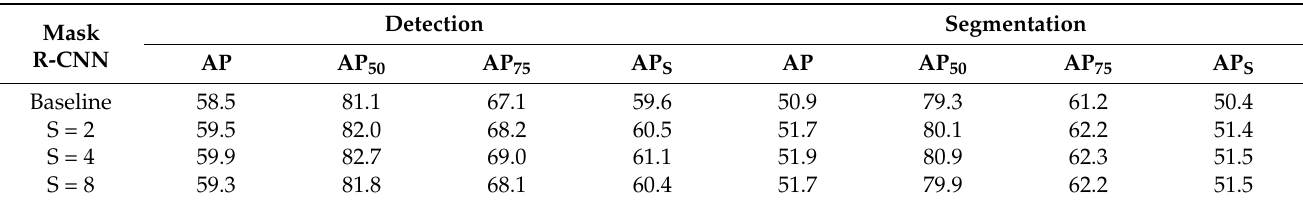
Table 5. The effect of scale variation on model performance.